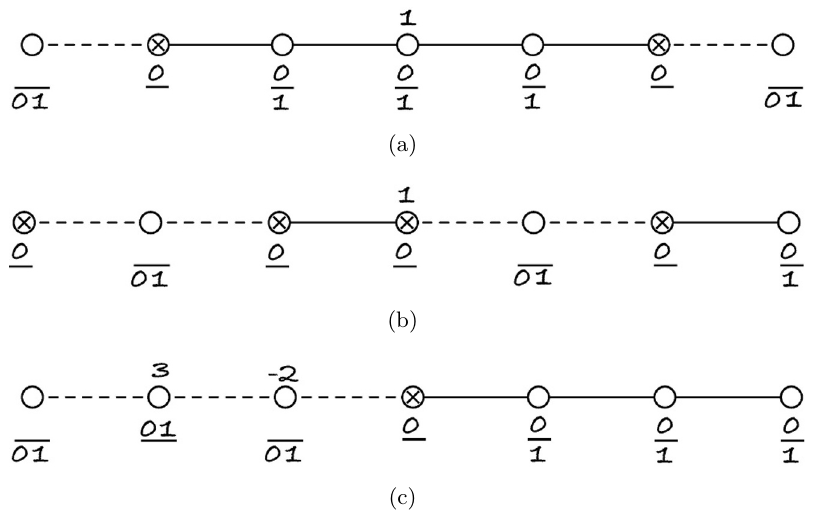
Figure 6 . Overlap formulae in different gradings, in graphic notations of figure 1: (a) for the Beauty diagram; (b) in the grading where a fermionic node is momentum-carrying; (c) in the grading corresponding to the distinguished Dynkin diagram of psu (2 , 2 | 4) (the Beast